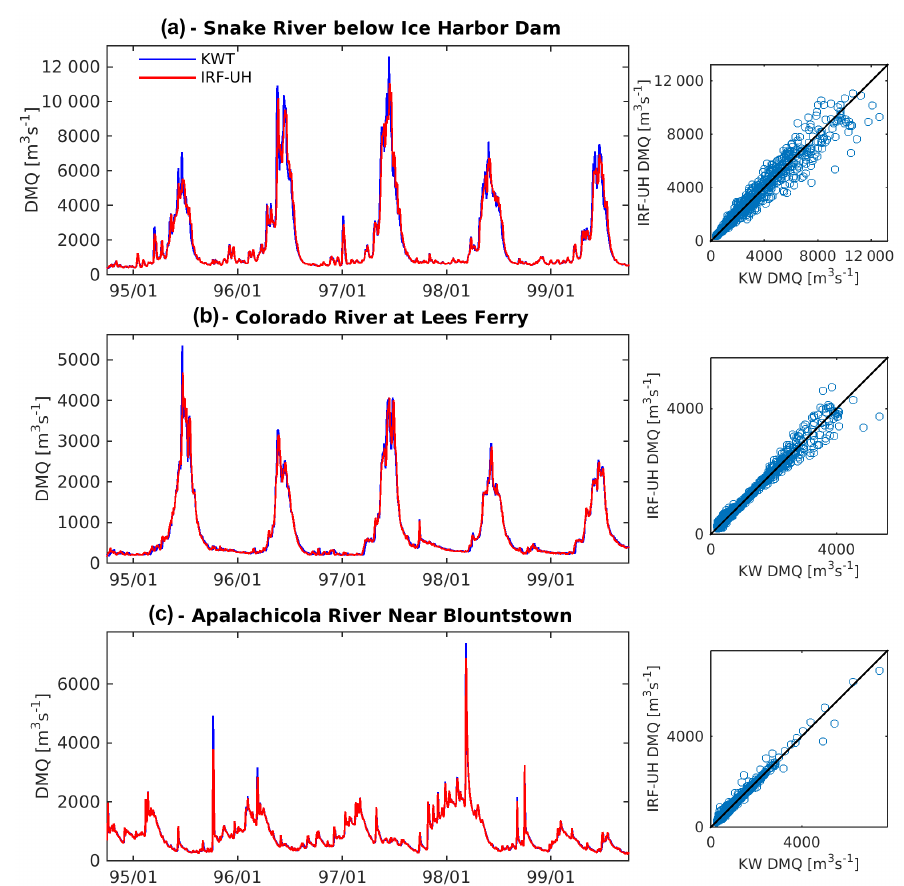
Figure 6. Daily mean streamflow (DMQ) at the three selected gauges in the GF river network. See Fig. 5 for the locations of the three